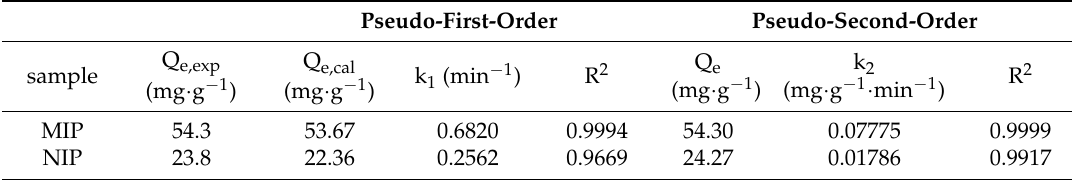
Table 3. Kinetic parameters for the adsorption of gossypol onto MIPs and NIPs prepared on 60 µ m spherical